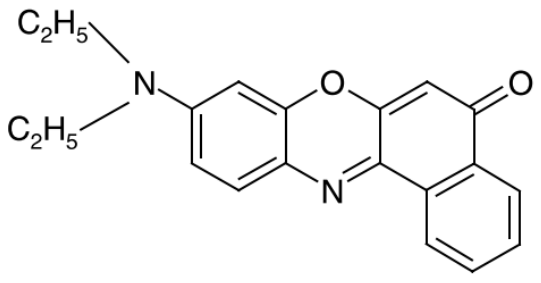
Figure 1. The structural formula of Nile red (NR).